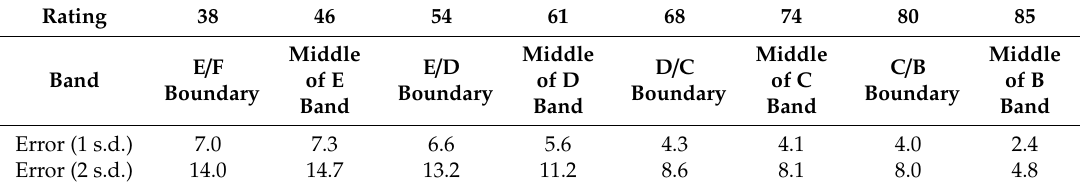
Table 2. Predicted error on certain EPC ratings. One and two standard deviation values given.